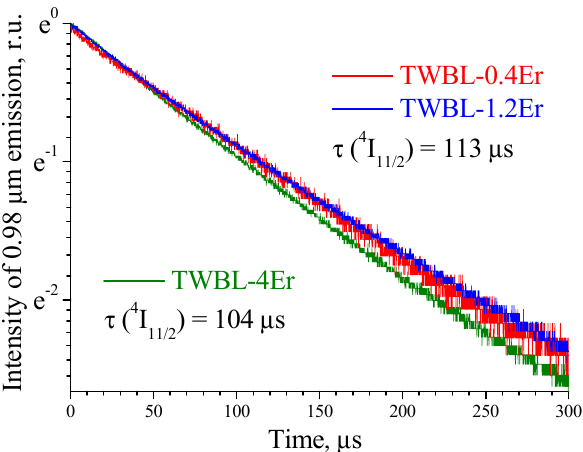
Figure 11. Decay curves of 0.98 µm luminescence from 4 I 11/2 level for TeO 2 -WO 3 -Bi 2 O 3 -(4-x) La 2 O 3 - xEr 2 O 3 glasses with Er 2 O 3 contents of 0.4, 1.2, and 4 mol%.